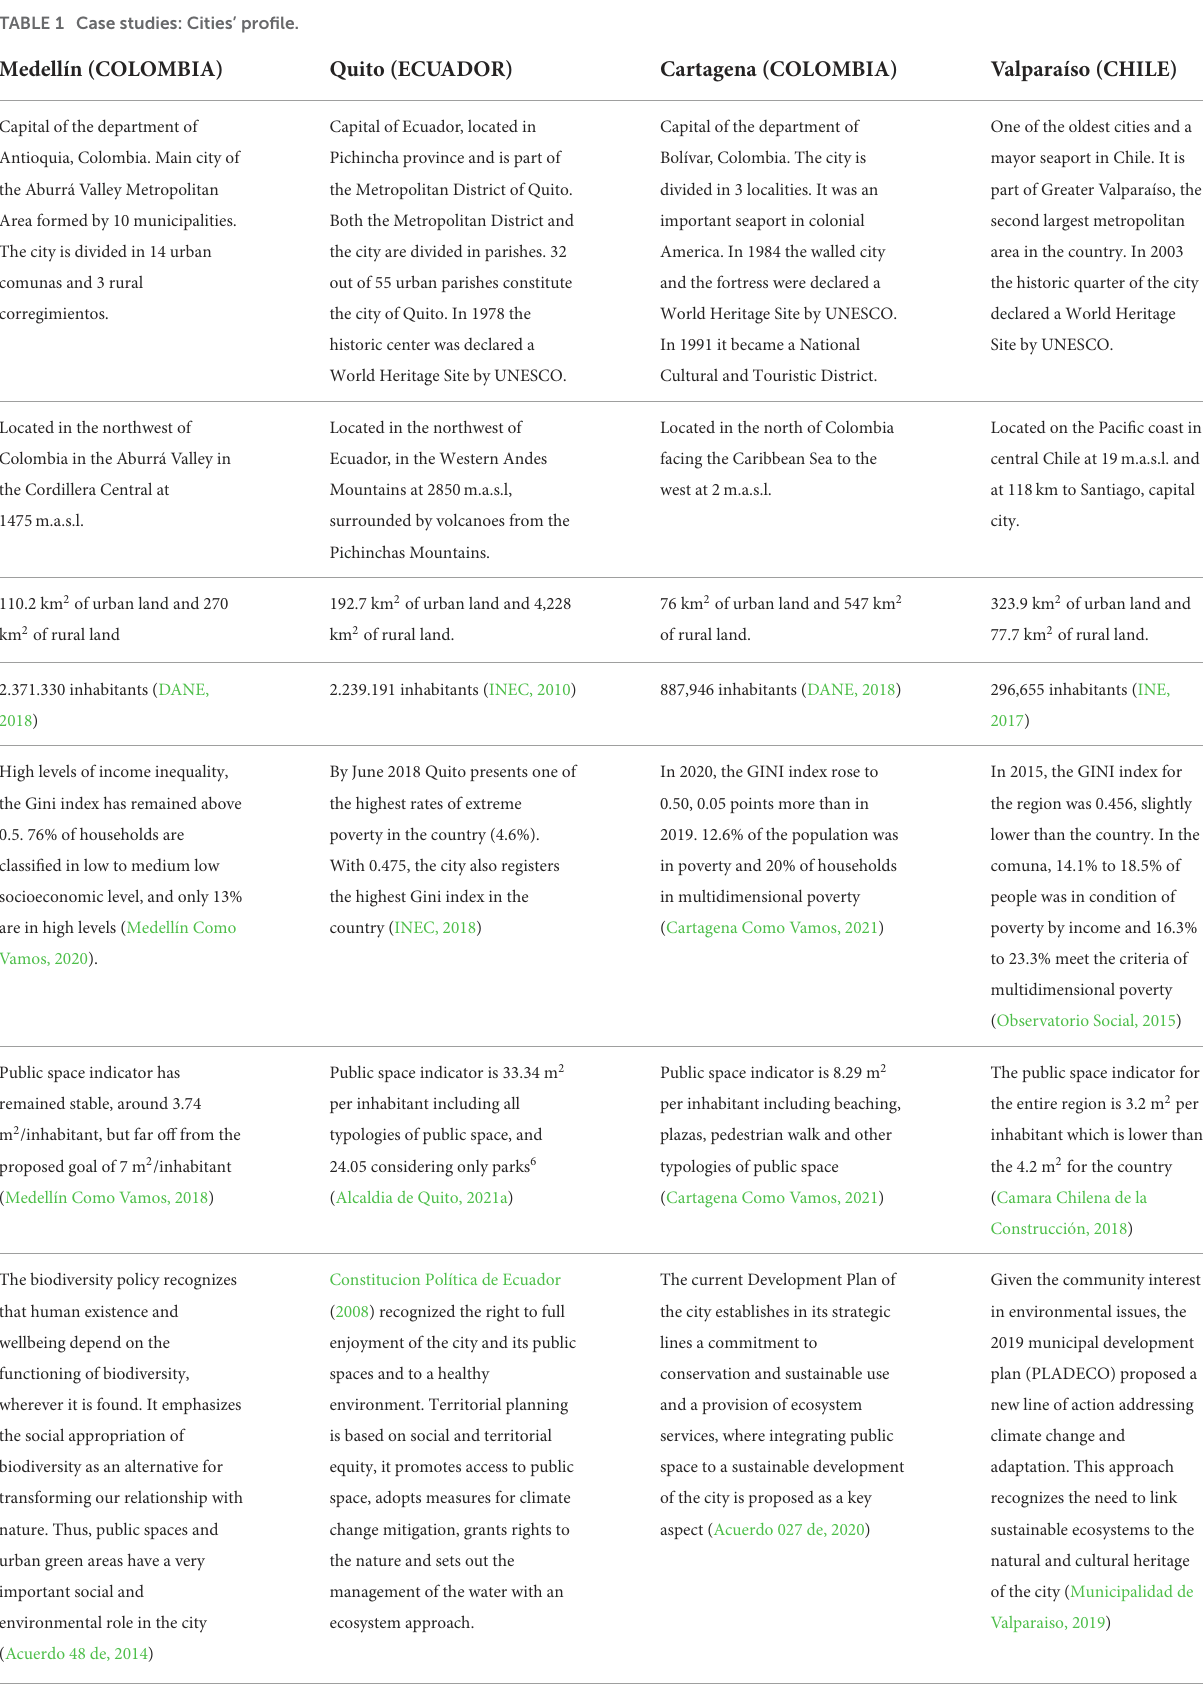
TABLE 1 Case studies: Cities’